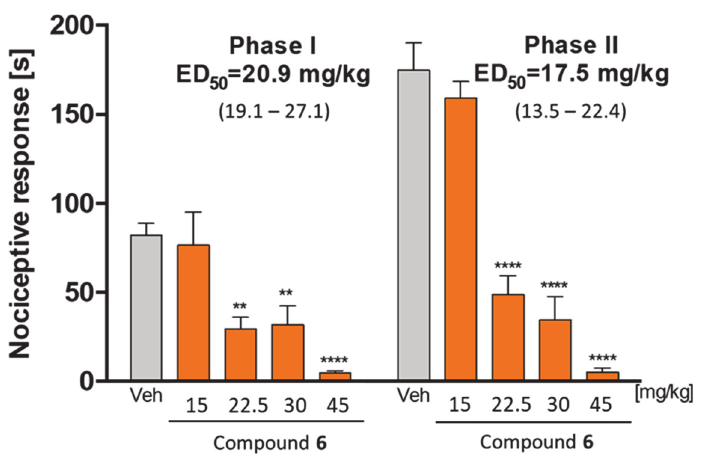
Figure 17. Antinociceptive activity of compound 6 in the formalin test. Results are shown as time of licking in phase I (0–5 min after intraplantar injection of formalin) and in phase II (15–30 min after formalin injection). Each value represents the mean ± S.E.M. for 8–10 animals. Statistical analysis: one-way ANOVA followed by post-hoc Dunnett’s test. Statistical significance compared to vehicle-treated animals (1% Tween 80): ** p < 0.01, **** p <